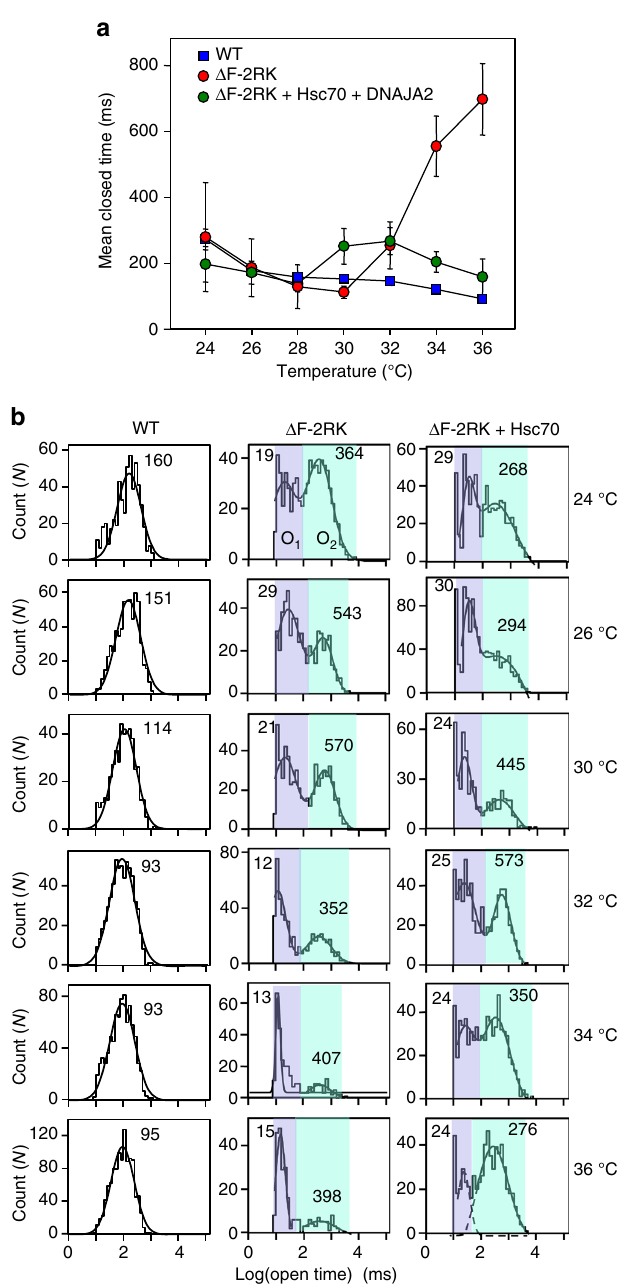
Fig. 5 Hsc70/DNAJA2 shifts the gating kinetics of single Δ F508-CFTR towards that of the WT during thermal unfolding. a The temperature dependence of mean closed times ( τ C ) of WT, Δ F508-2RK and Δ F508-2RK with Hsc70/DNAJA2 was determined from dwell time histograms restricted to single channel records of Δ F508-2RK (total recording time was 10 – 28 min, n = 5 – 24), Δ F508-2RK with Hsc70/DNAJA2 (15 – 25 min, n = 10 – 23) and WT (4 – 7 min, n = 3 – 7). Data are means ± SEM. b Open dwell time histograms of single WT, Δ F508-2RK and Δ F508/2RK channels with Hsc70/DNAJA in the BLM. Histograms were fi tted with one or two components Gaussian distribution. The mean O1 and O2 times